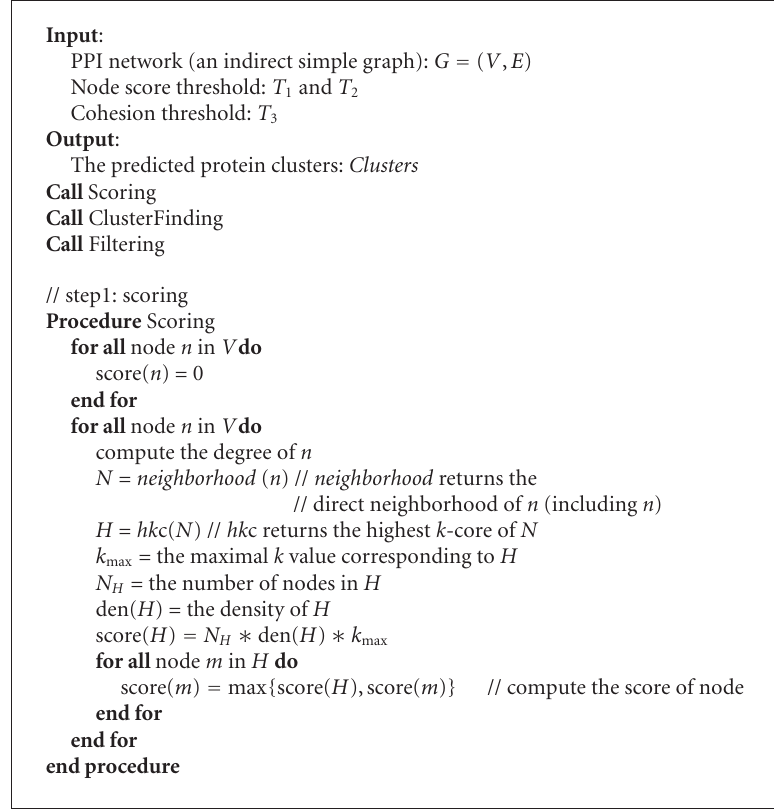
Pseudocode 1: Procedure